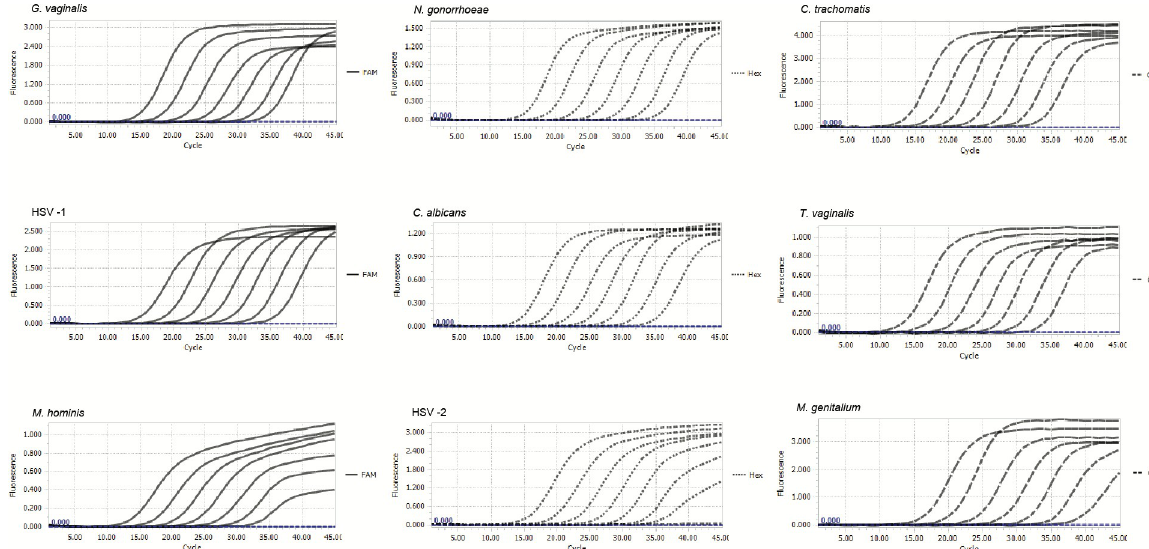
Fig 1. Amplification plots of “in-house” real-time PCR assay using double-quenched TaqMan probes for nine pathogens. Standard plasmids at seven 10-fold reducing concentrations in the range of 5 × 10 2 –5 × 10 8 copies/reaction (plots were presented from the left to the right).